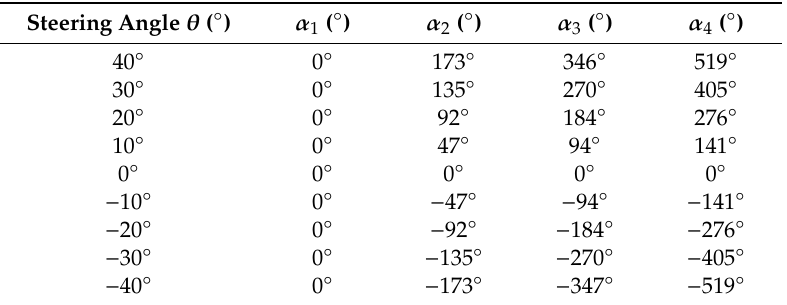
Table 1. Beamforming phase weights.